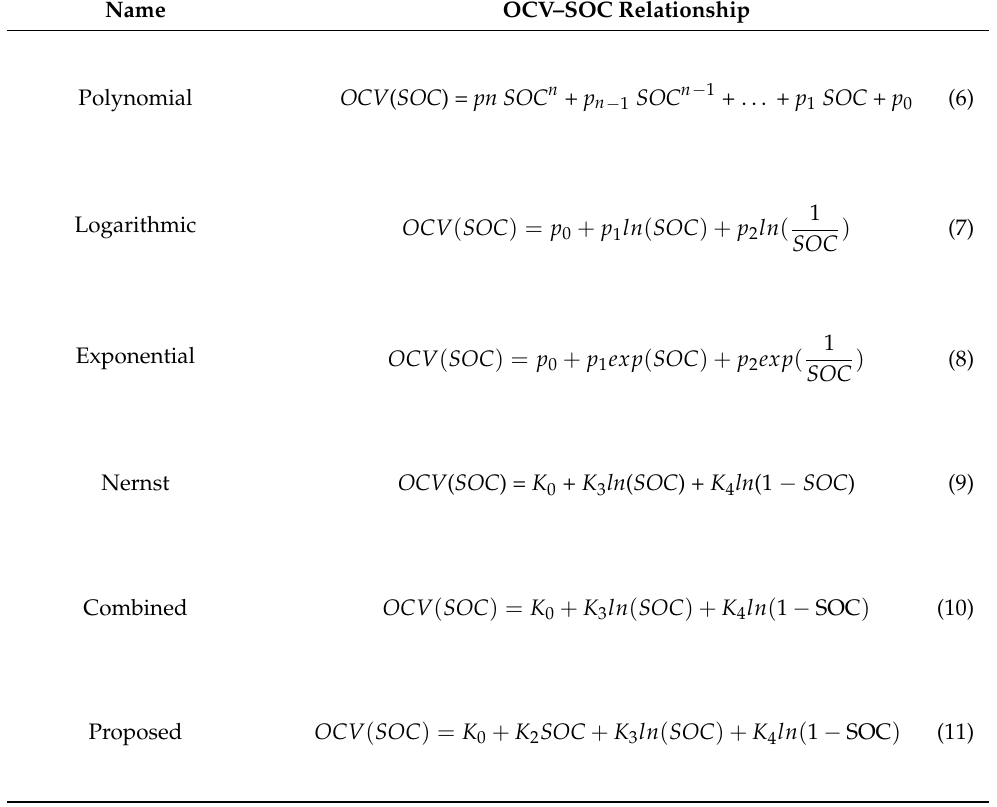
Table 2. Overview of OCV